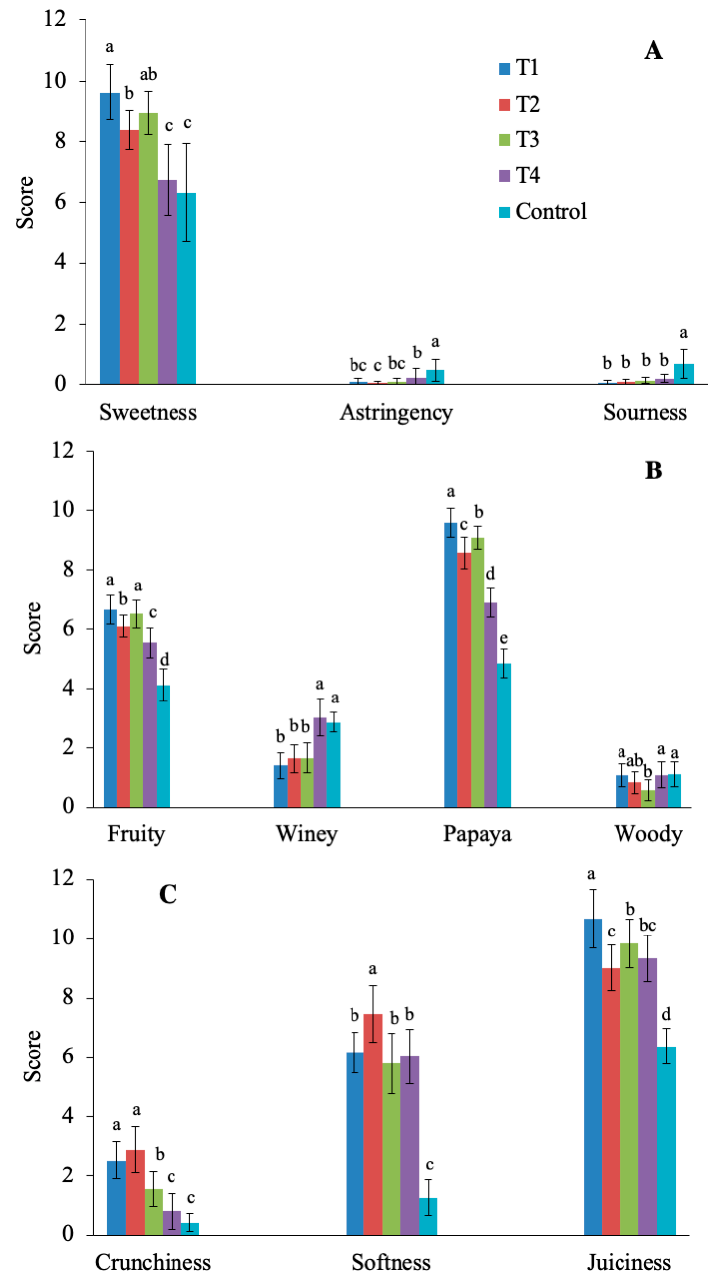
Figure 2. Sensory evaluation of the attributes of taste ( A ), odour ( B ), and texture ( C ), as evaluated in ‘Maradol’ papayas from plants grown under different production schemes and stored at 30 ± 2 °C and 80% RH. The bars represent the average values from eight trained judges. The lines on the bars indicate the standard deviations. A common letter per attribute denotes statistical equality (Tukey’s test, p > 0.05). T1 = blue bar, T2 = red bar, T3 = green bar, T4 = purple bar, and control = blue bar. For the details of the treatments, see Table 1.